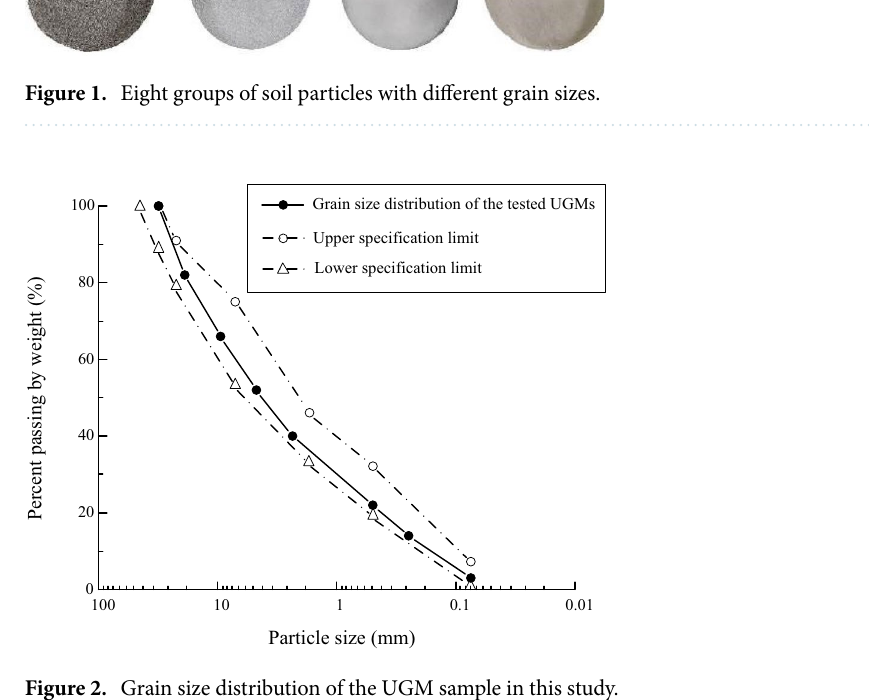
Figure 2. Grain size distribution of the UGM sample in this